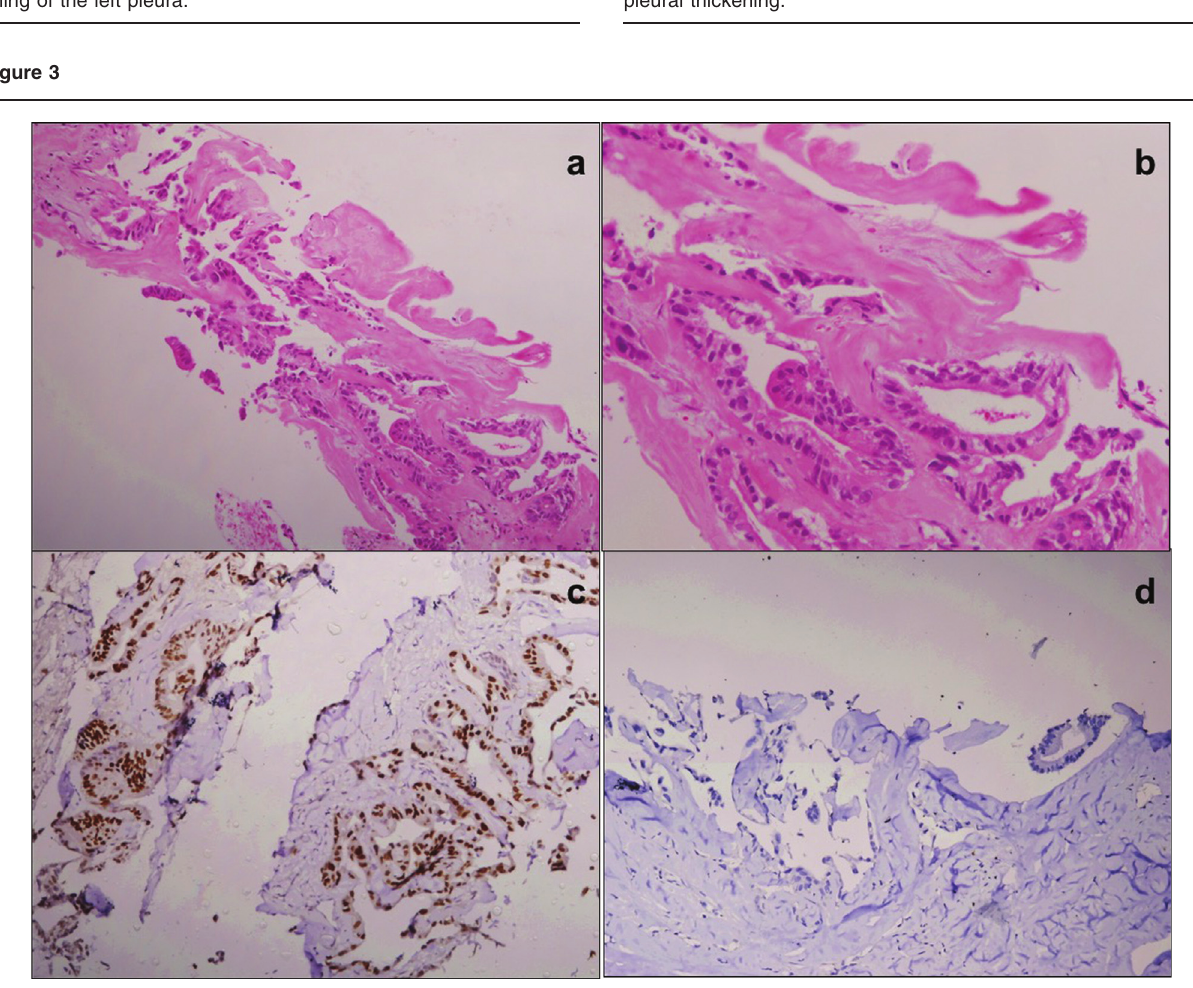
Computed tomography of the chest showing diffuse, nodular thick- ening of the left